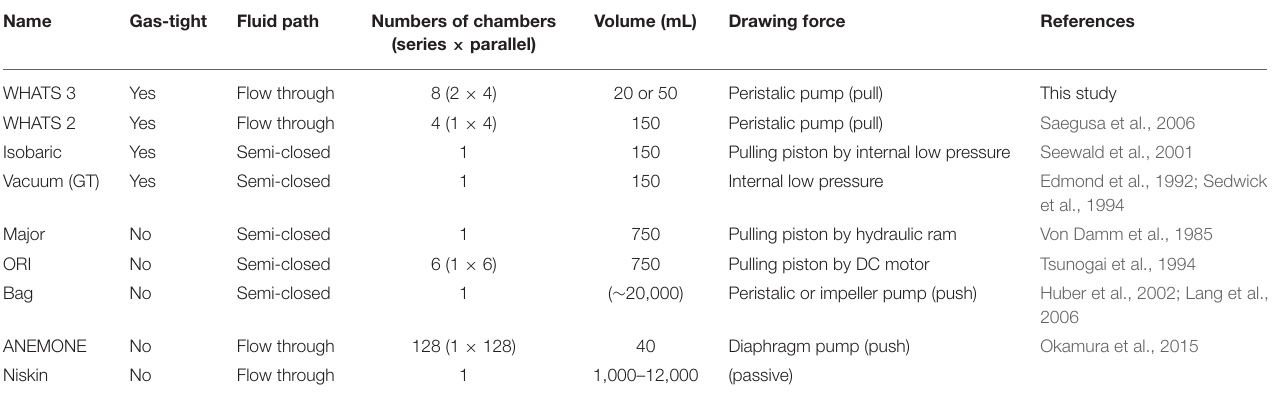
TABLE 1 | Comparison of deep-sea geofluid